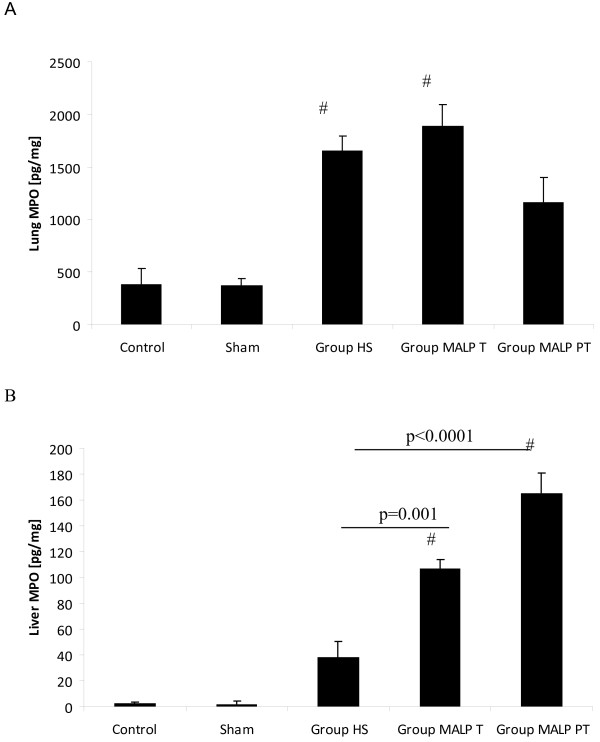
Pulmonary (A) and liver (B) myeloperoxidase (MPO) activity in C57/BL6 mice; Animals were subjected either to MALP-2 pre-treatment (12 hours) (Group MALP PT) or MALP-2 was administered following HS (90 minutes) (Group MALP T).Group HS: hemorrhagic shock with PBS administration after 90 minutes. Results are expressed as means ± SE of 6 animals per group (#<0.05 vs. Control/Sham).